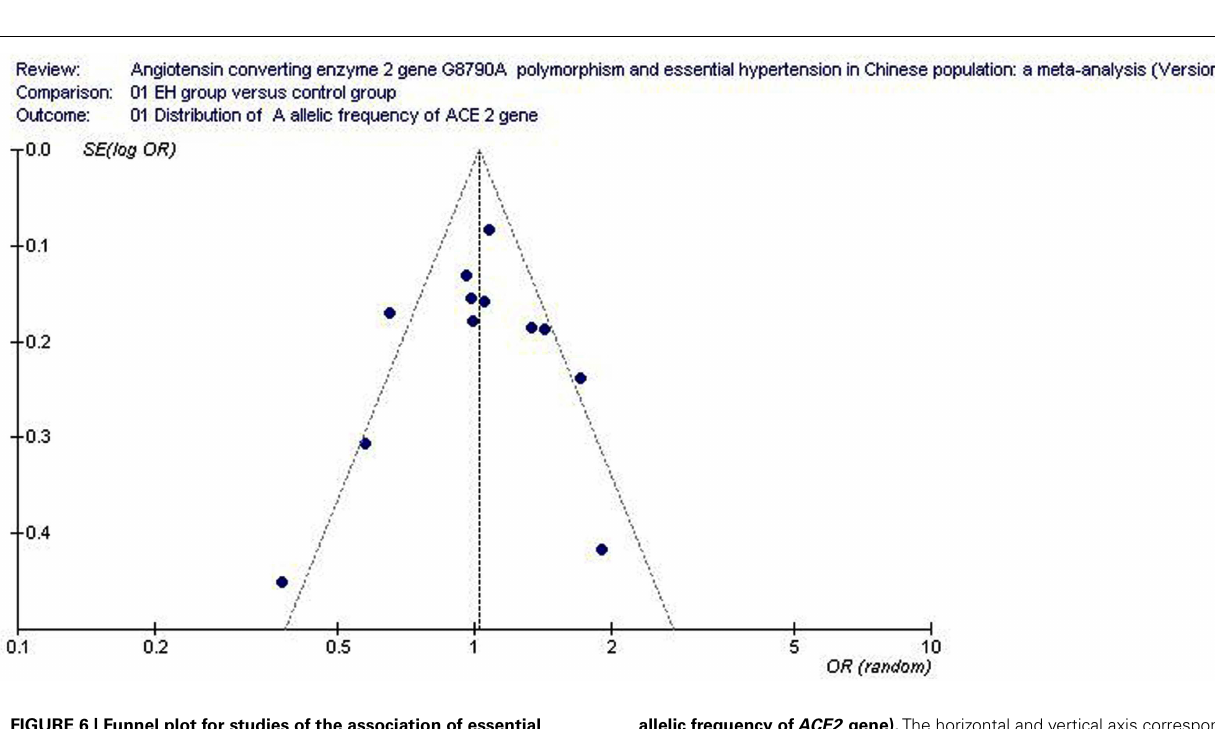
allelic frequency of ACE2 gene). The horizontal and vertical axis correspond to the OR and confidence limits. OR, odds ratio; SE, standard